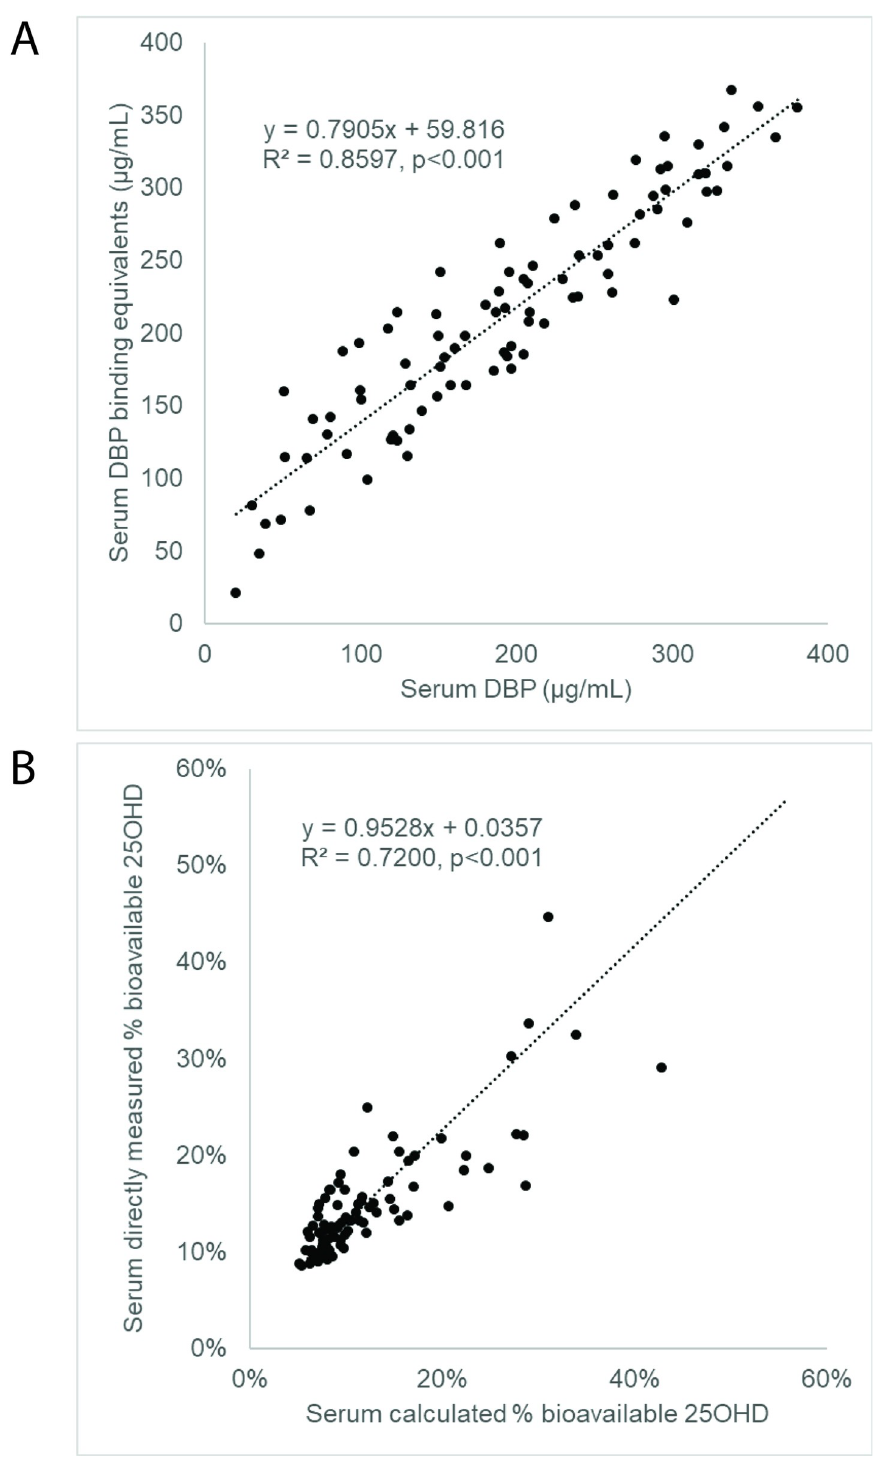
Fig 3. Linearity of relationships between serum DBP, DBP binding equivalents, and calculated % bioavailability of 25OHD. (A) Linear relationship between DBP binding equivalents measured by DBP-binding assay and serum DBP measured by LC-MS/MS. (B) Linear relationship between 25OHD % bioavailability measured by DBP-binding assay and calculated 25OHD % bioavailability.